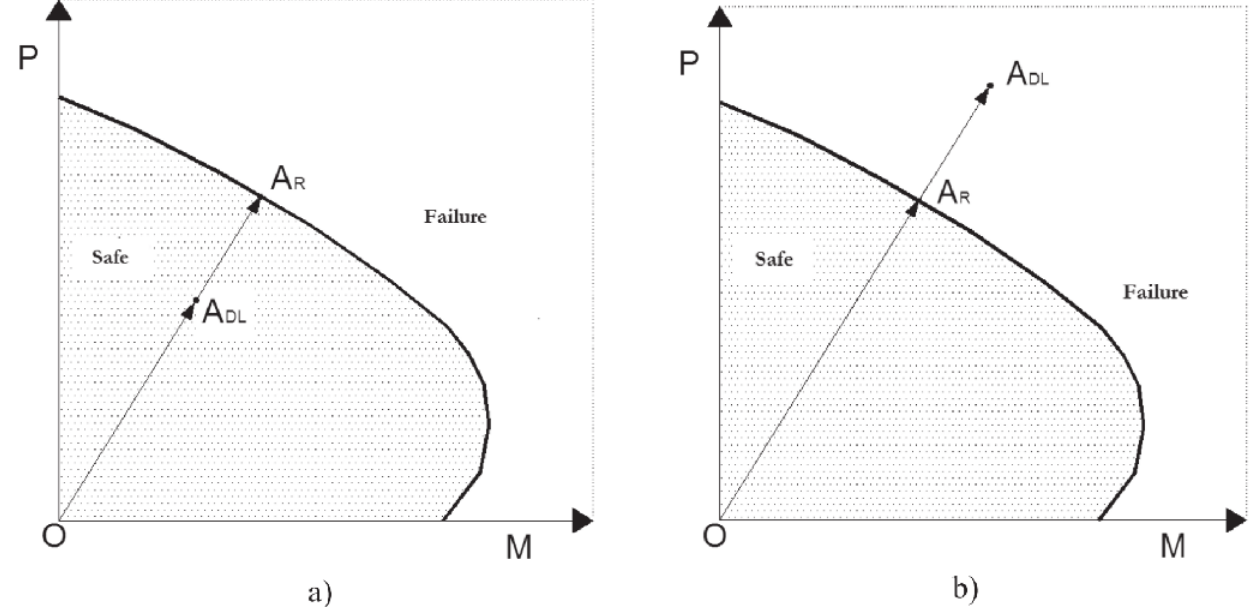
Interaction diagrams and limit state functions for eccentric column loading